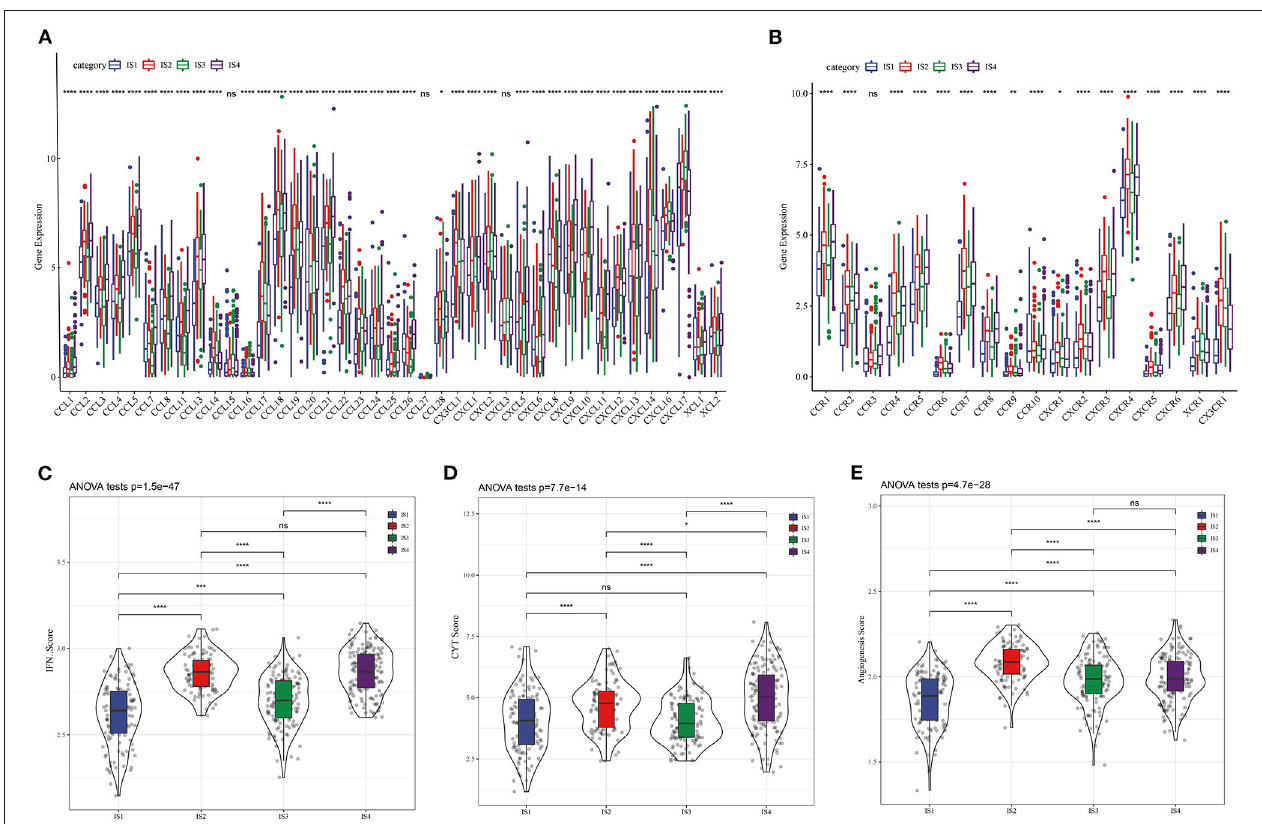
FIGURE 3 | Four LUAD subtypes showing different phenotype. (A) Expression of chemokine in four LUAD subtypes. (B) Expression of chemokine receptors in LUAD subtypes. The difference of (C) IFN γ score, (D) CYT score, and (E) angiogenesis scores among four